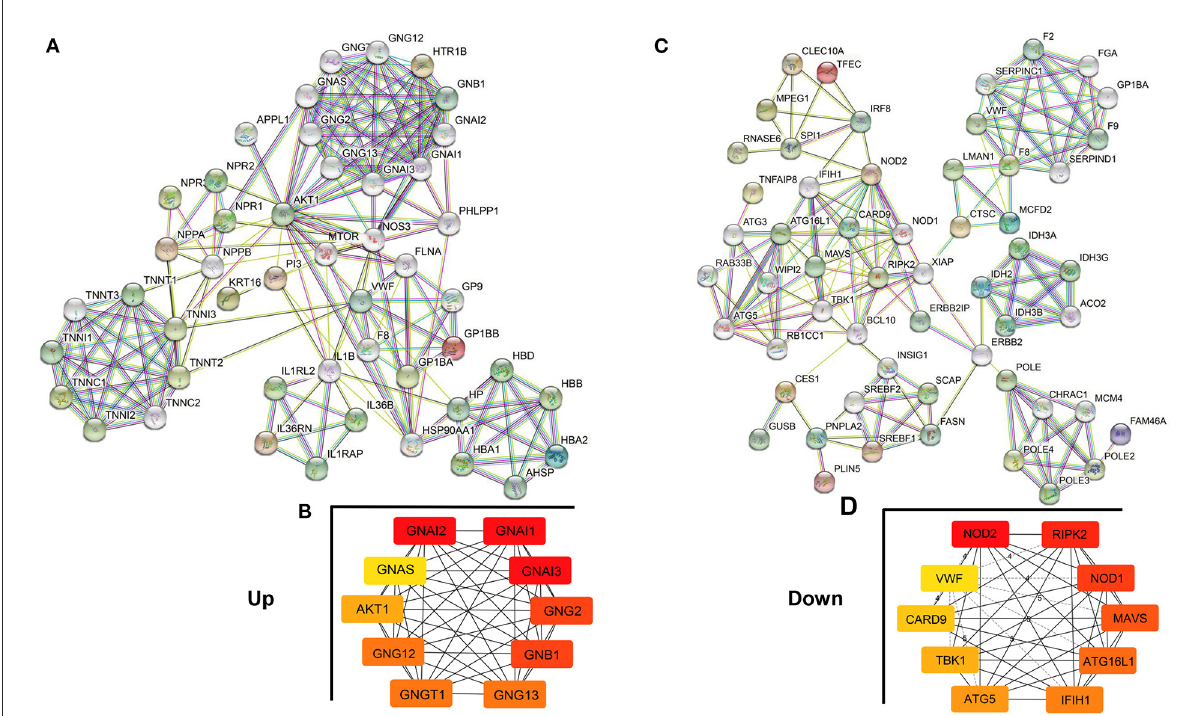
FIGURE7 Protein–Protein Interaction (PPI) network analysis of genes in the co-expression network. (A,B) PPI network and hub genes in the upregulated co-expression network. (C,D) PPI network and hub genes in the downregulated co-expression network. The edges represent the interaction between two nodes, and the number of edges in one node is called the degree of the PPI